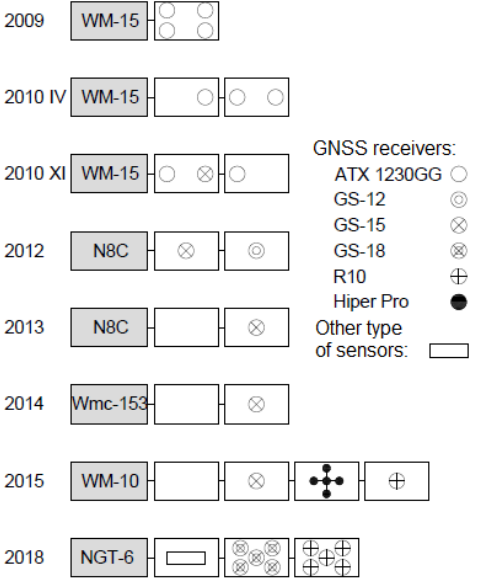
Figure 1. Scheme of the distribution of GNSS receivers in each measurement campaign.